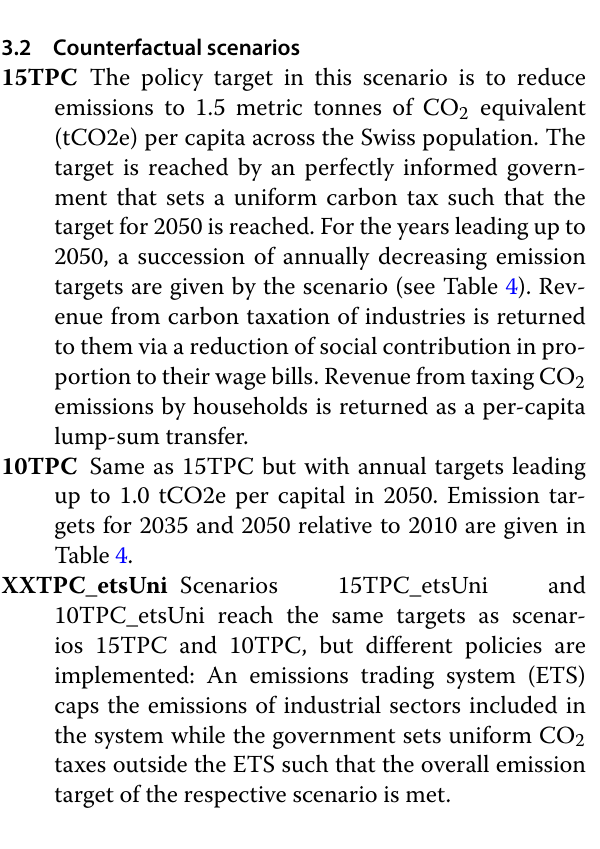
Table 3 Time trends of Swiss economic indicators and policies